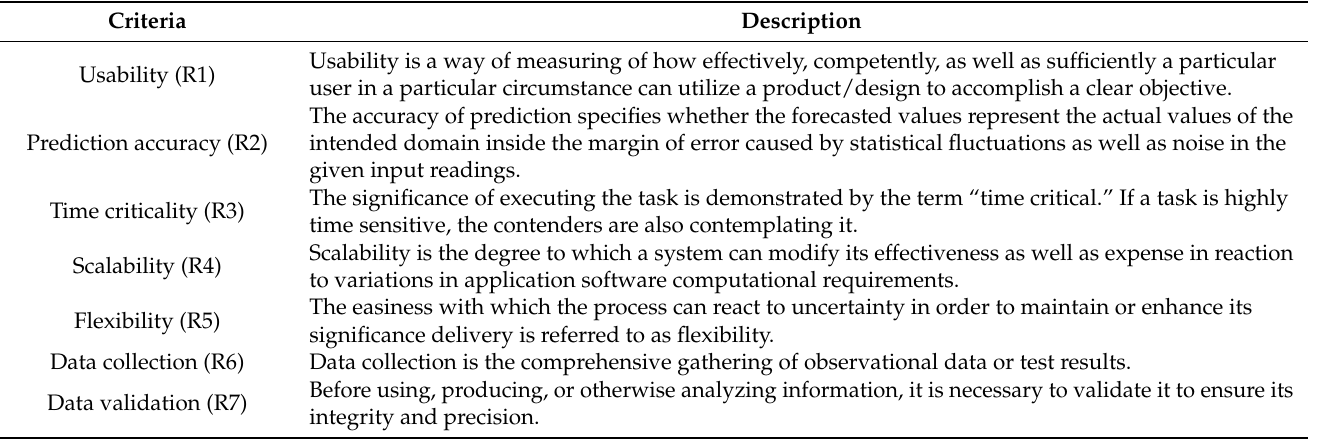
Figure 2. Hierarchical structure for the MCDM assessment. Table 1. Different identified evaluation criteria with their